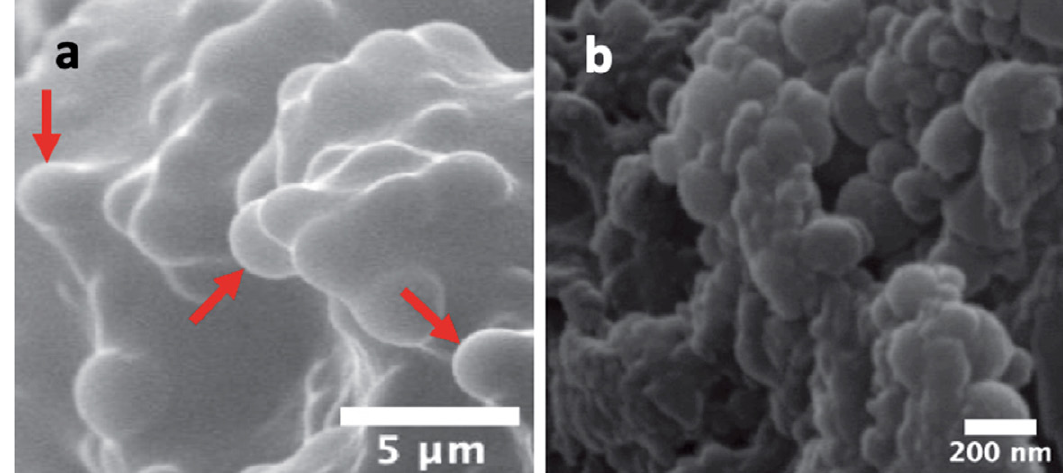
Figure 3 . SEM images of P-P-3 sample in as-centrifuged state a) general view of the surface of a large sized agglomerate, 10k magnification, b) a closer view of the surface of a random sphere seen in (a), 100k magnification